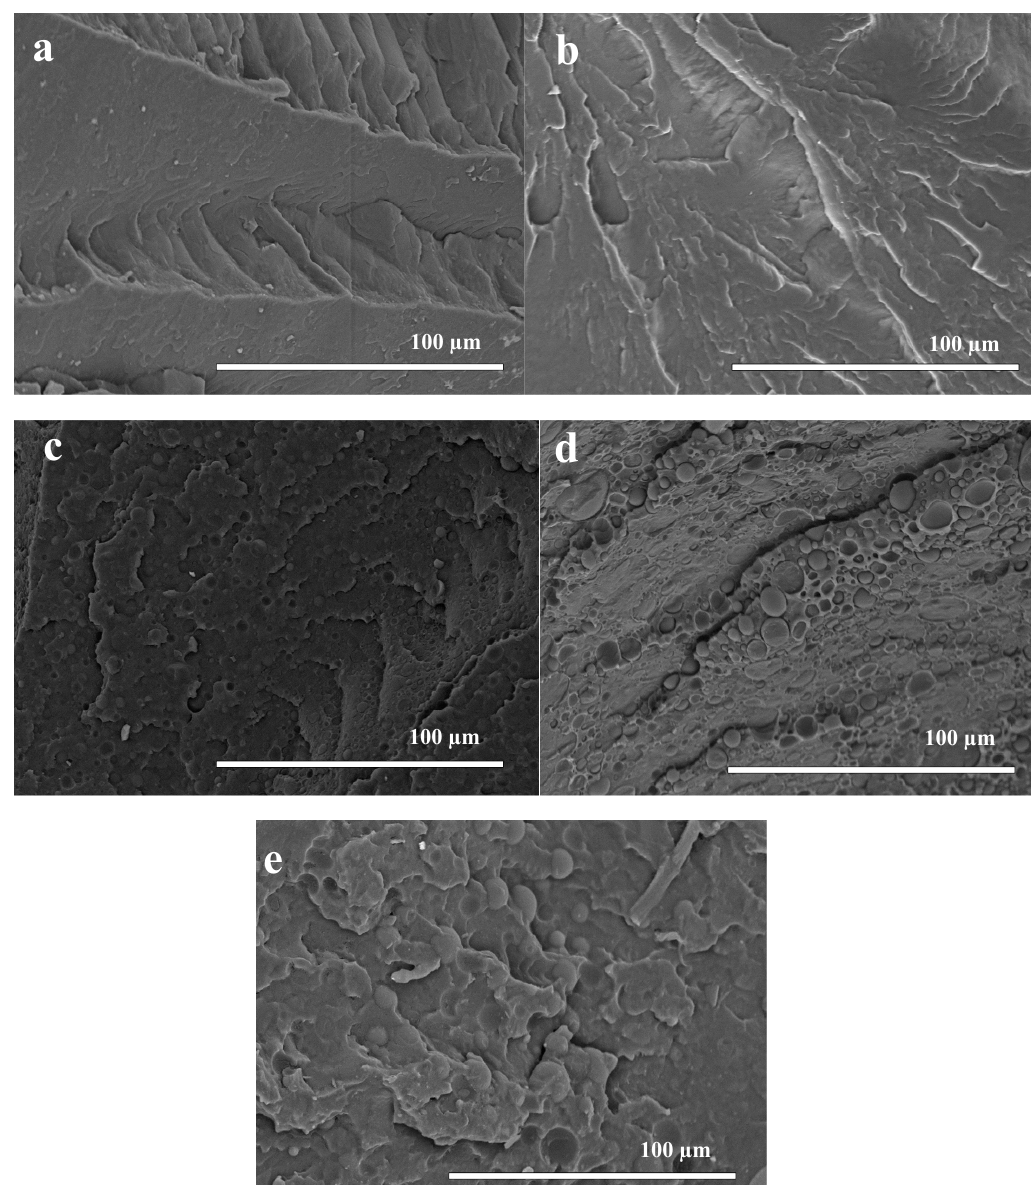
Figure 1. SEM micrographs (cryogenic fracture surface) of the cross-section for the homopolymers and their blends: ( a ) PLA100, ( b ) PBAT100, ( c ) PLA70, ( d ) PLA60, ( e ) PLA50.